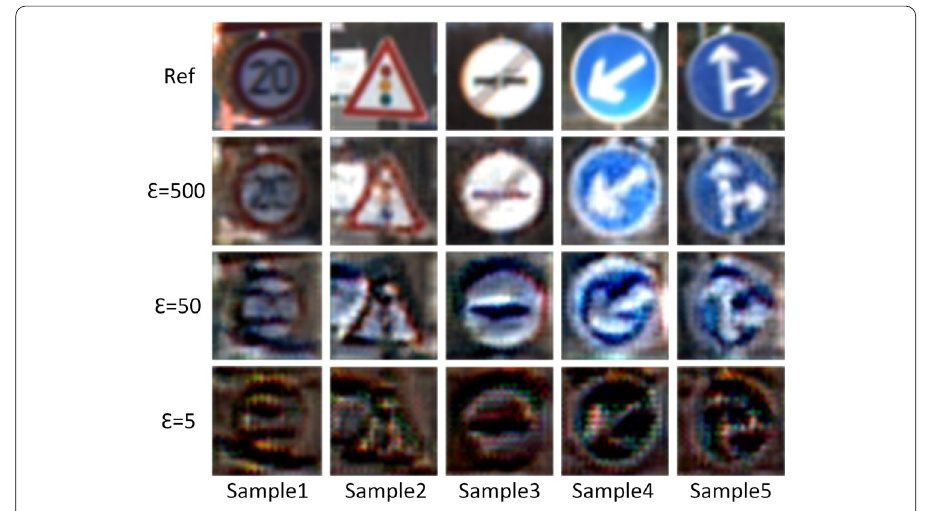
Fig. 4 Recovered images under model perturbation defense